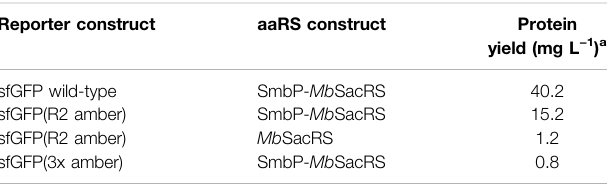
TABLE 2 | Puri fi ed yields of ncAA-modi fi ed target protein as measure for OTS ef fi ciency with 2 mM sac provided in the growth medium. Reporter